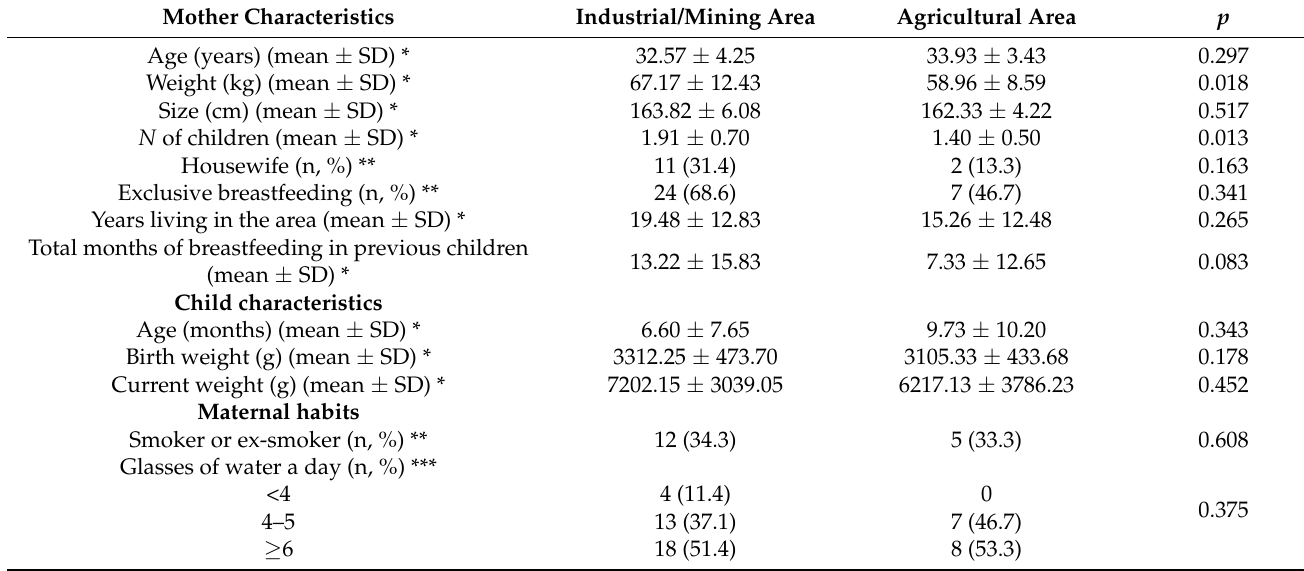
Table 1. Characteristics of the mothers, children and maternal nutrition according to the group (industrial–mining area vs. agricultural